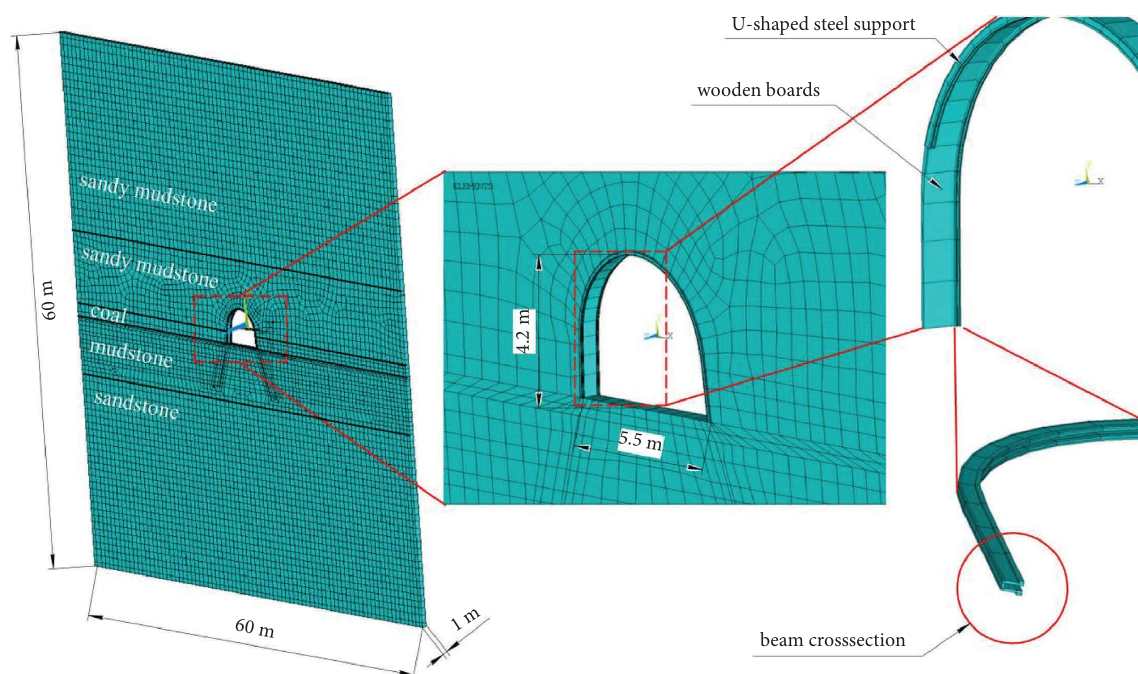
Figure 5: Numerical simulation model and supporting units.